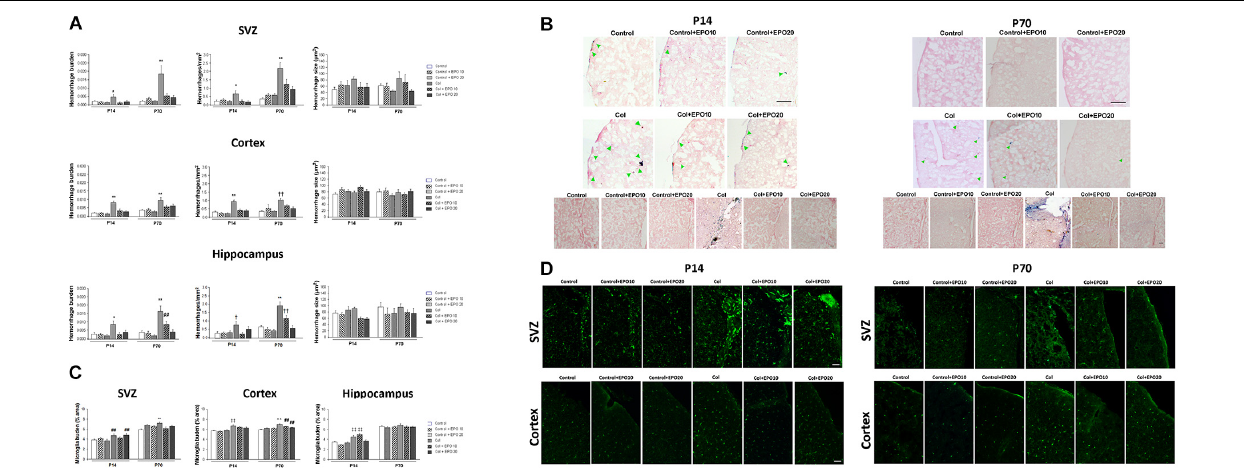
FIGURE 3 | EPO treatment reduces vascular damage and inflammation after inducing a GM-IVH. (A) Hemorrhage burden was significantly increased in the SVZ after Col lesions and EPO10 and EP20 treatments reversed this effect, both in the short (P14) and the long term (P70) (P14: * p = 0.013 vs. rest of the groups and P70: ** p < 0.01 vs. rest of the groups). The number of individual hemorrhages was reduced after EPO treatment (P14: * p = 0.021 vs. rest of the groups; P70: ** p < 0.01 vs. rest of the groups), while individual hemorrhage size was not affected (P14: p = 0.169]; P70: p = 0.440]. When we analyzed the cortex we observed a similar profile and increased hemorrhage burden, after Col lesions, was reduced by EPO treatment (P14: ** p < 0.01 vs. rest of the groups; P70: ** p < 0.01 vs. rest of the groups), due to a reduction in the number of individual hemorrhages after the treatment (P14: ** p < 0.01 vs. rest of the groups; P70: †† p < 0.01 vs. Control, Control + EPO10, Control + EPO20 and Col + EPO20), while hemorrhage size was not affected (P14: p = 0.123; P70: p = 0.296). In the hippocampus, increased hemorrhage burden in the ipsilateral side was reversed by EPO administration (P14: * p = 0.02 vs. rest of the groups; P70: ** p < 0.01 vs. rest of the